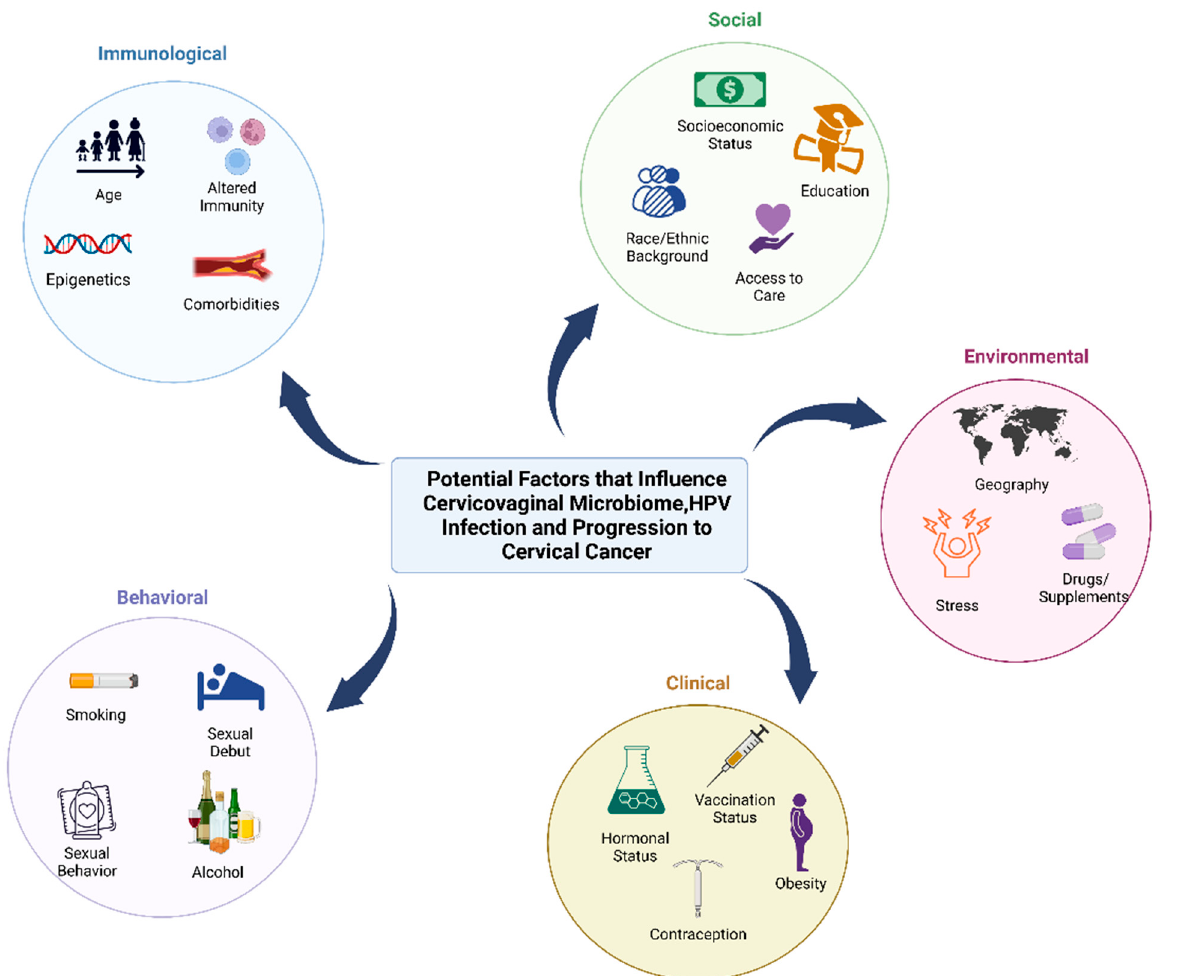
Figure 1. Behavioral, clinical, environmental, social, and immunological factors that may contribute to cervicovaginal microbiome, HPV infection, and progression to cancer. Factors that can impact the microbiome and host that increase the risk of HPV infection and cervical cancer can be influenced by behavioral factors (smoking, age of sexual debut, sexual activity such as use of lubricants and sex toys, contraception, feminine hygiene practices, and alcohol consumption), clinical factors (hor- monal status, contraception, vaccination status, and hormonal dysregulation conditions such as obesity), environmental factors (geographic location, stress and trauma, and use of drugs/supple- ments or antibiotics), social factors (socioeconomic status, race or ethnic background, education level, and access to care), and immunological factors (age, epigenetics, altered immunity, and comorbidities such as cardiovascular